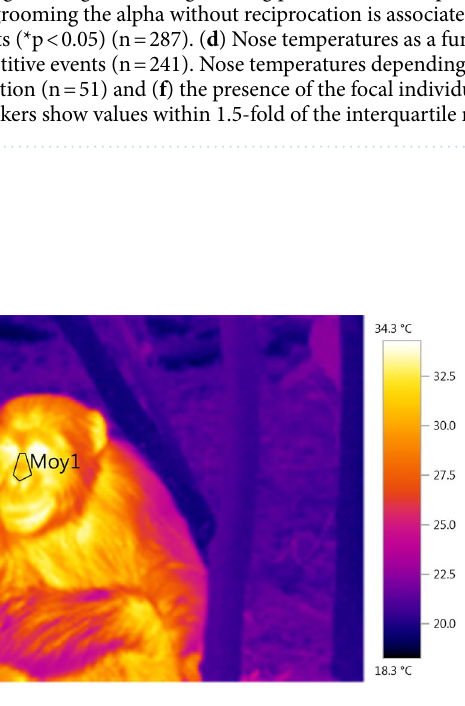
Figure 3. A thermal picture of a chimpanzee taken after the arrival of a dominant male. The black contour labelled "Moy1" represents the region of